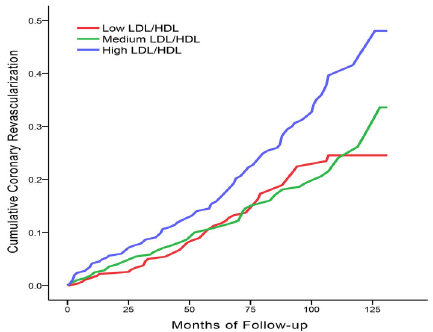
Figure 1. Kaplan-Meier cumulative hazard curves of coronary revascularization in the three groups. Log-rank test showed that the chi-squared value between the low LDL/HDL group and the high LDL/HDL group was 7.290, P=0.007, and the chi-squared value between the medium LDL/HDL group and the high LDL/ HDL group was 8.105, P=0.004. LDL: low-density lipoprotein; HDL: high-density